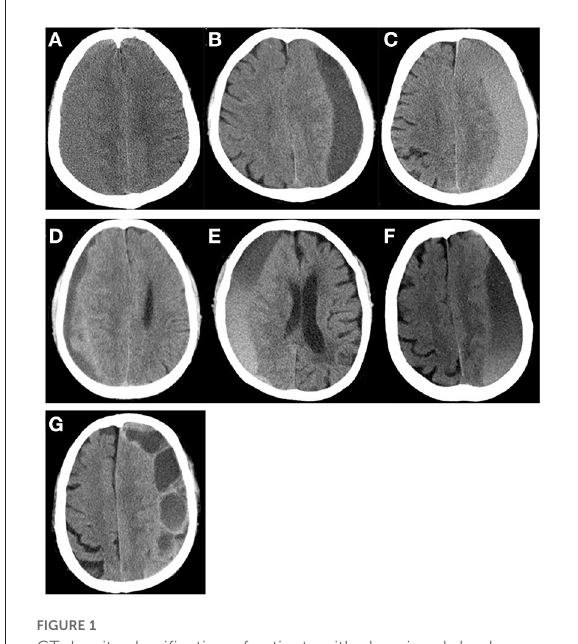
FIGURE1 CT density classification of patients with chronic subdural hematoma. (A) isodense subtype, (B) hypodense subtype, (C) hyperdense subtype, (D) laminar type, (E) separated type, (F) gradation subtype, (G) trabecular